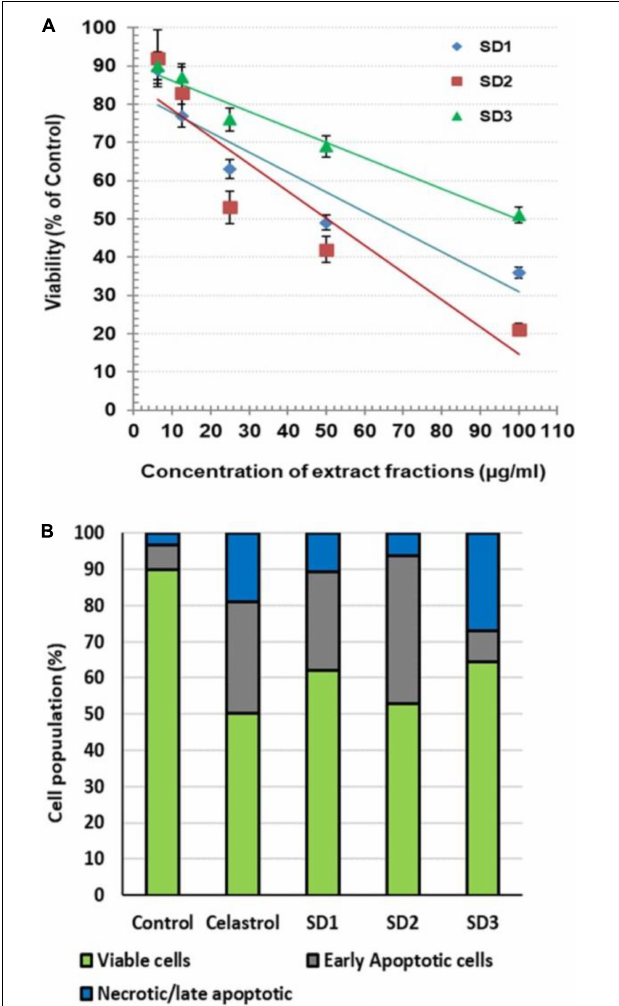
FIGURE 2 | (A) Cytotoxic effect of S dentifolium extract fractions (SD1, SD2, and SD3) on CAL-27 cells after 48 h of incubation, as assayed by MTT. The viability is expressed as percentage of control (mean ± SD; n = 8). (B) A segmented histogram indicates the percentage of cell population distribution of vital, early apoptotic, and late apoptotic/necrotic cells after being treated with IC 50 of celastrol or S dentifolium fractions (SD1, SD2, and SD3) for 48 h compared to